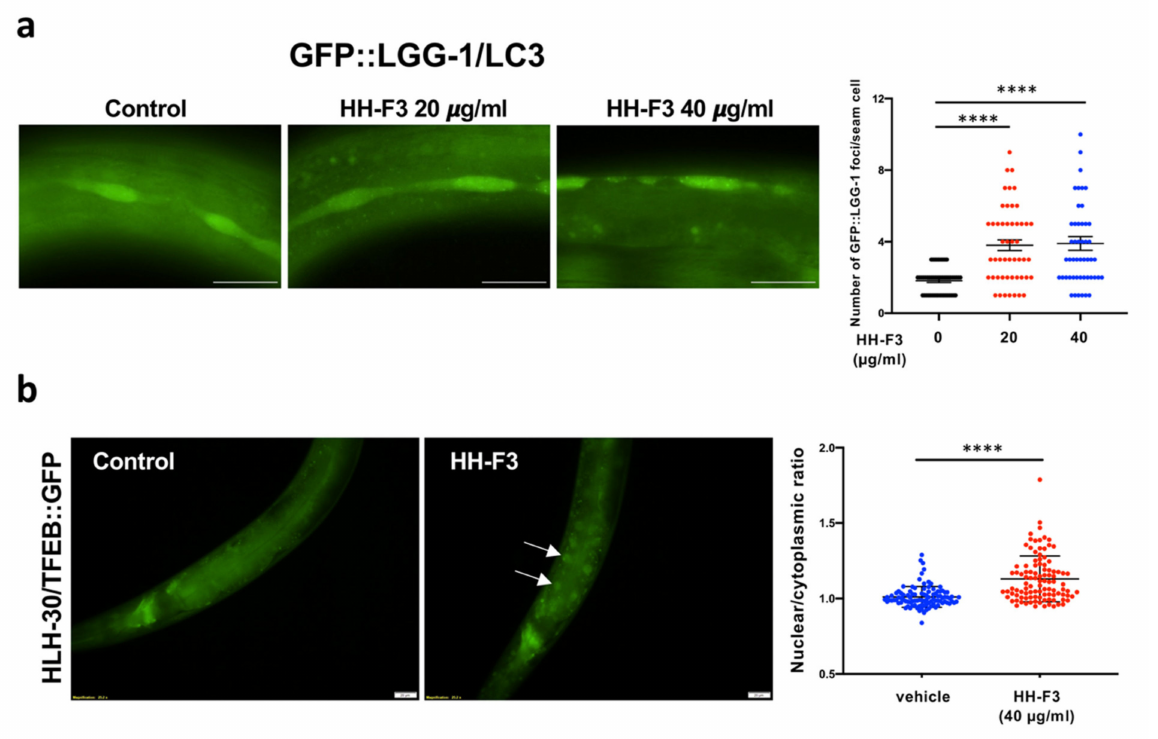
Figure 5. GP extract HH-F3 activated autophagy in C. elegans. ( a ) GFP::LGG-1/LC3 punctae were examined in the hypodermal seam cells of L3 larval stage animals expressing lgg- 1 p::gfp::lgg- 1 treated with 0, 20, and 40 µ g/mL HH-F3 from hatching (n > 20). (**** p < 0.0001, One-way ANOVA test) ( b ) Distribution of HLH-30/TFEB::GFP was visualized in Day 1 adult worms expressing hlh- 30 ::gfp treated with 40 µ g/mL HH-F3 from hatching. The nuclear/cytosol ratios of HLH-30::GFP in the intestinal cells are shown. (**** p < 0.0001, Chi-squared